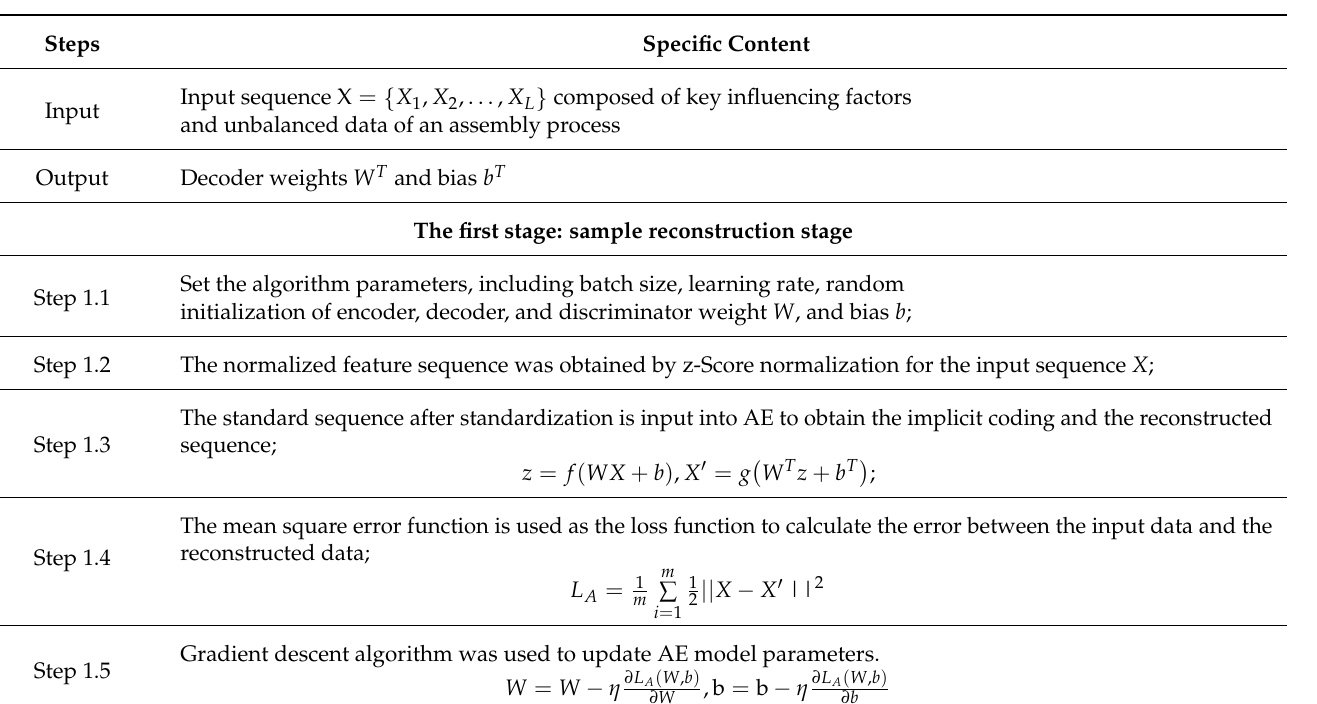
Table 1. Training process of AAE